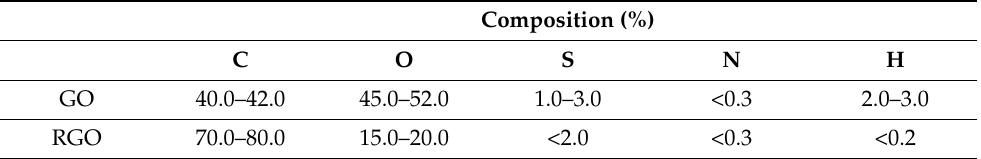
Table 1. Elemental analysis of graphene oxide and reduced graphene oxide.